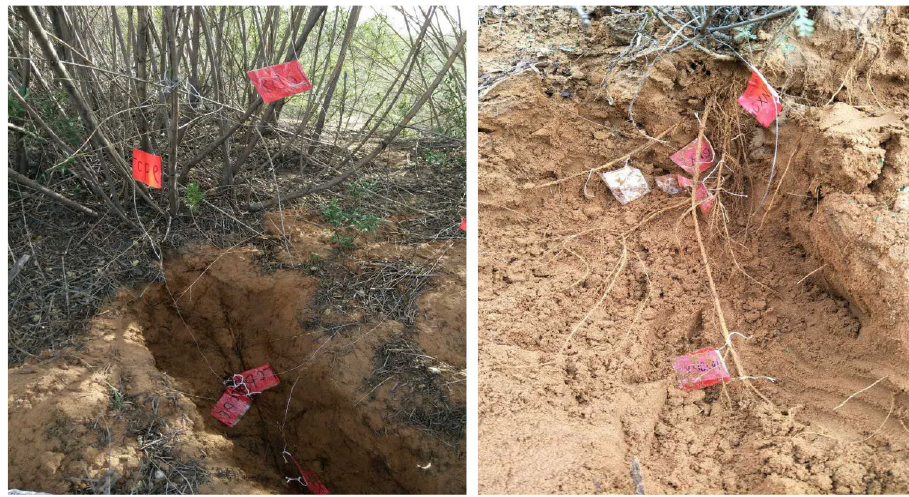
Figure 2. Excavation phase of test roots.